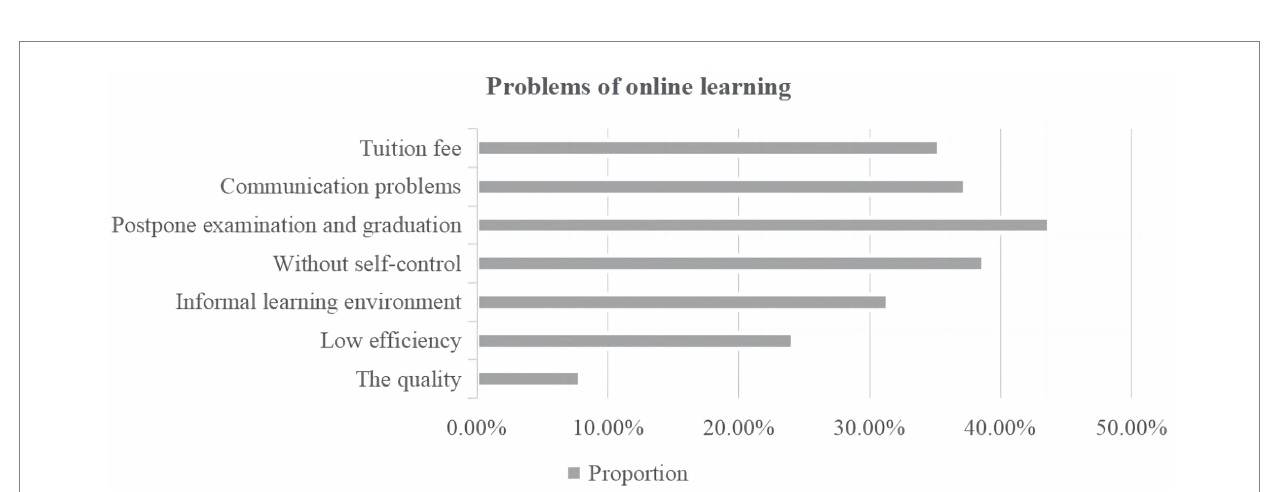
FIGURE 2 Concerns of online